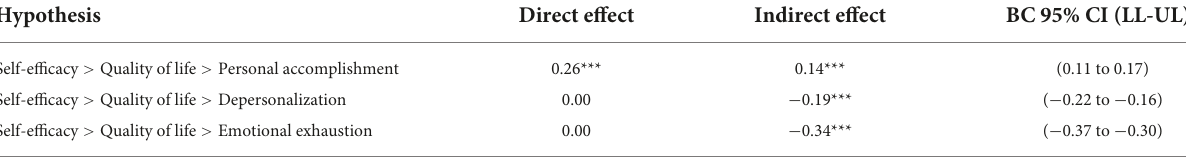
TABLE 3 Standardized effect from mediation analysis – final model (bootstrapping with 5.000 samples; Bias-corrected 95%